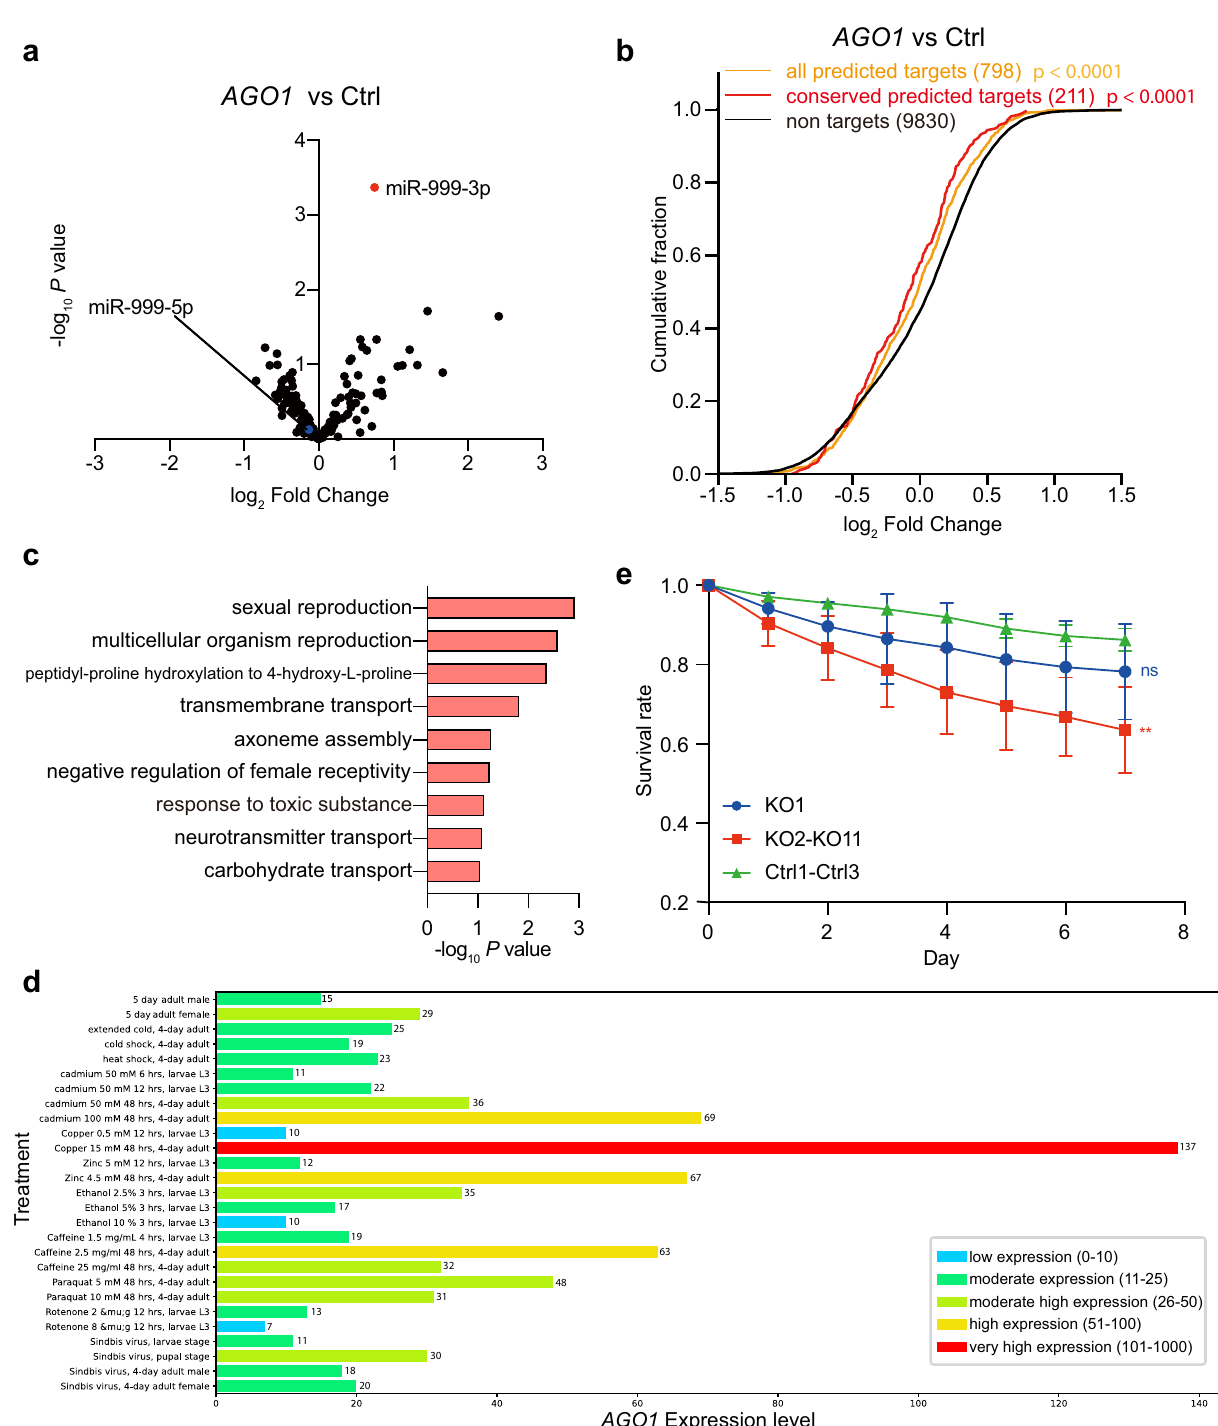
Fig. 7 | AGO1 trigger-KO fl ies are more vulnerable to stress. The in fl uence of TDMDtriggeronmiR-999( a )andrepressionofmiR-999targets( b )in AGO1 trigger KO fl ies. Differences between each set of predicted targets and non-targets were assessed for statistical signi fi cance using the Mann – Whitney test (two-sided) and the associated P value. P value=8.9×10 − 5 (<0.0001) for all predicted targets compared with non-targets, and P value=7.1×10 − 5 (<0.0001) for conserved pre- dicted targets compared with non-targets. c DAVID identi fi ed GO term biological pathwaysenrichedindownregulatedgenesin AGO1 triggerKO fl iescomparedwith